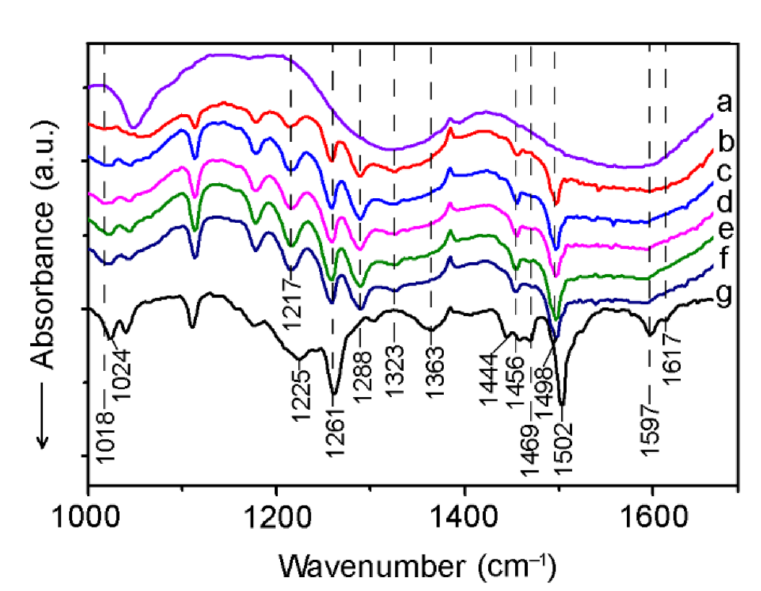
Figure 2. Fourier transform-infrared (FT-IR) spectra of pure CeO 2 (a), samples of G/CeO 2 with different contents of G (0.1: b; 0.3: c; 0.6: d; 0.9: e; 1.2 mmol/g: f) and pure G